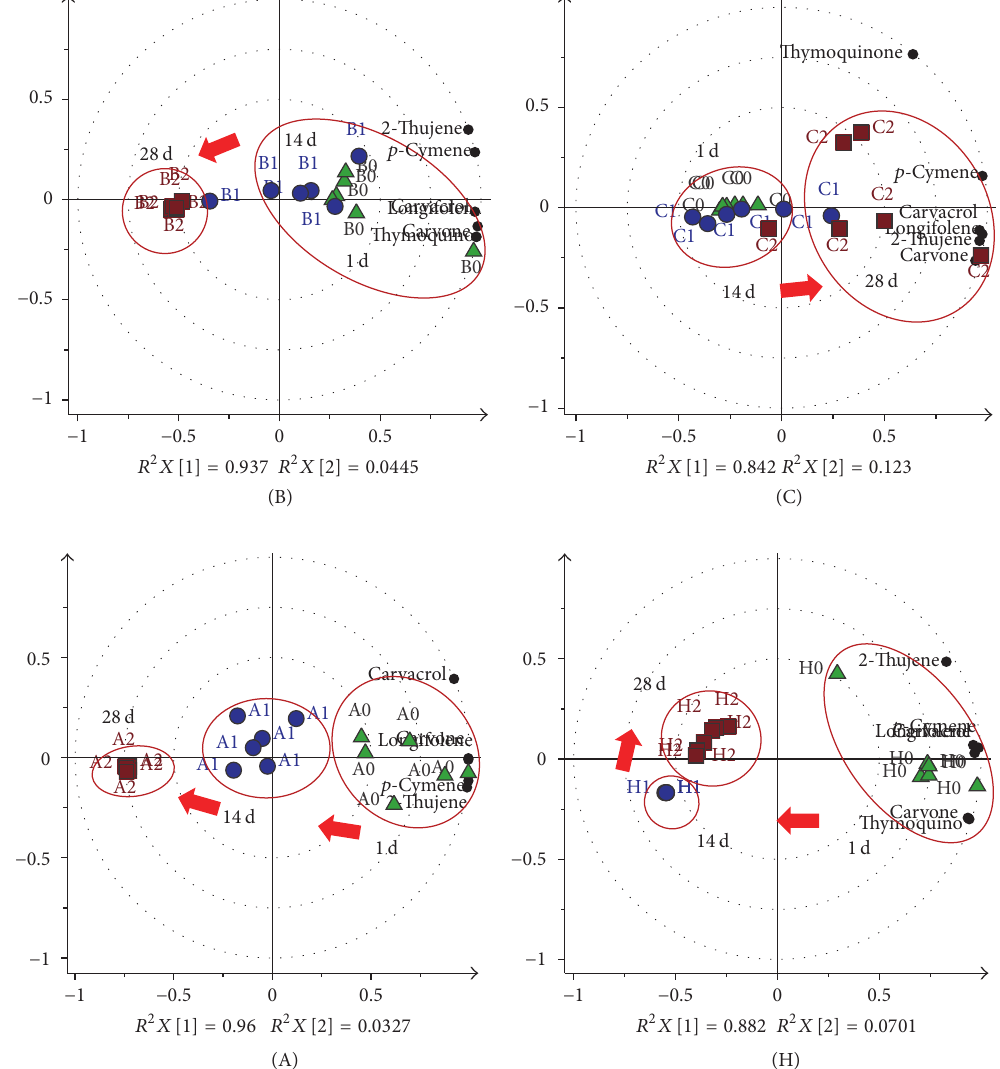
Figure 4: The biplot model of the principle component analysis (PCA) for storage to determine the effects of heat and light; 1st (green triangle), 14th (blue circle), and 28th (red square) day. The smaller black circles are those identified compounds from the